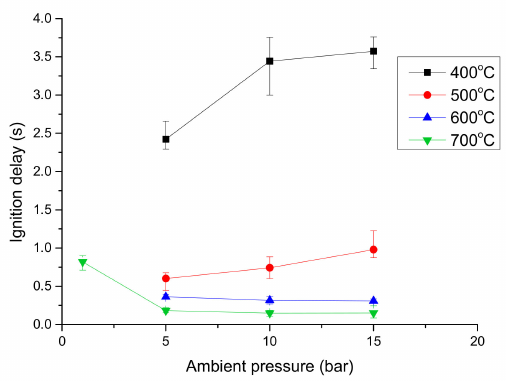
Figure 9. Ignition delay of a diesel droplet at various ambient temperatures and